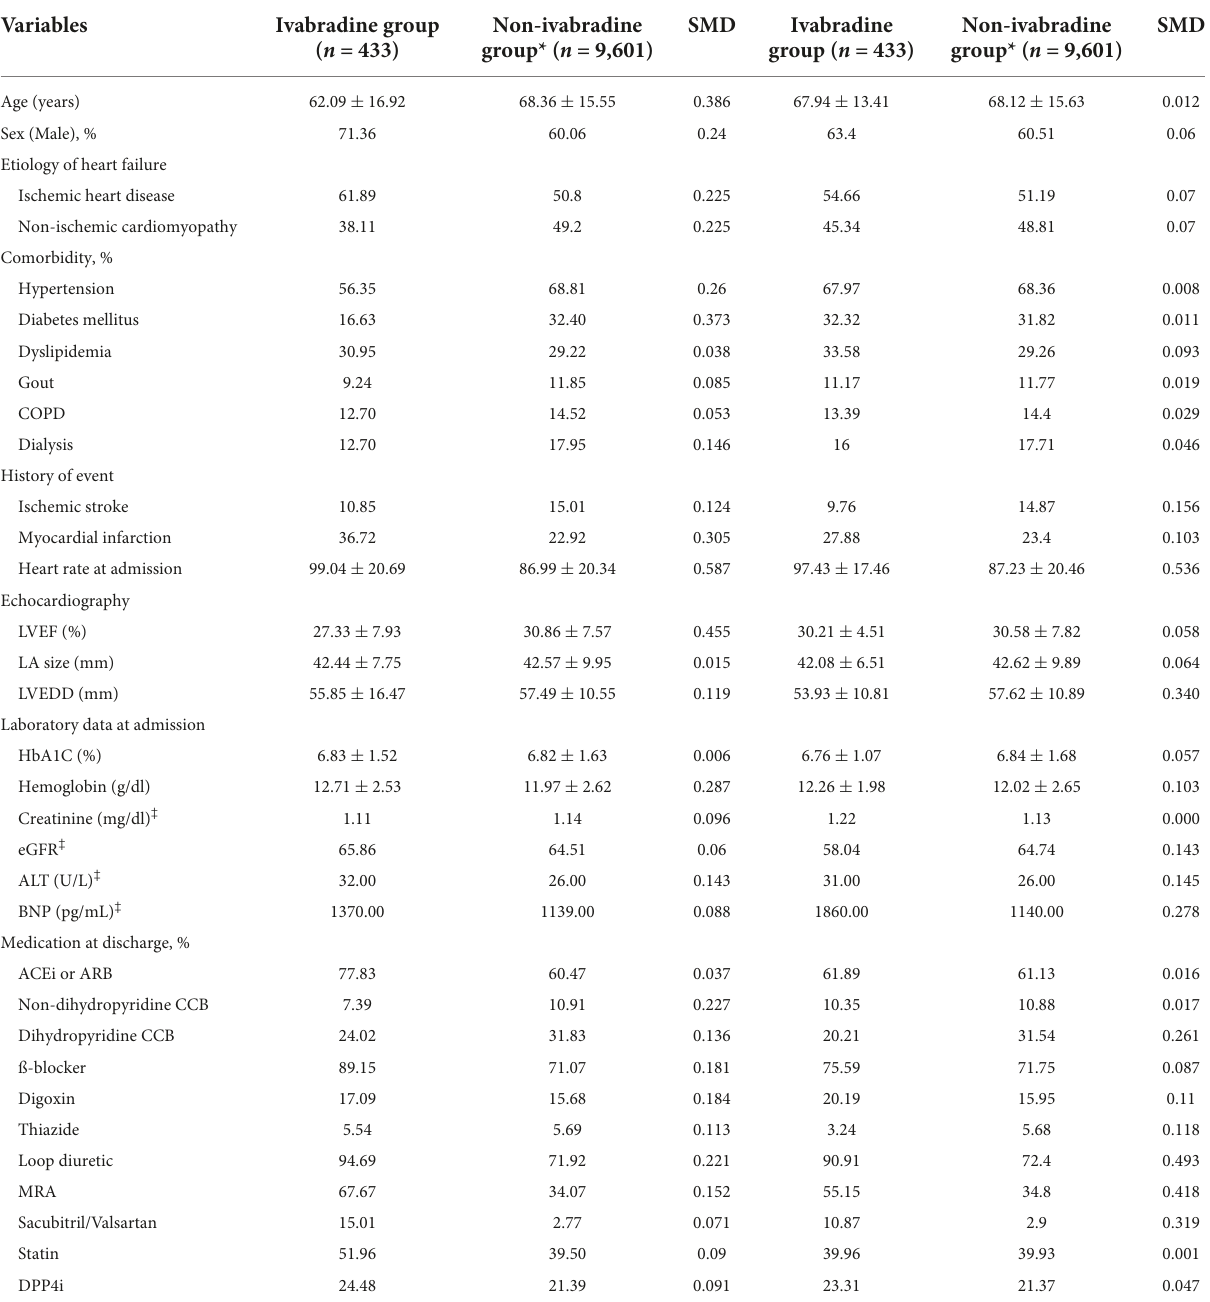
TABLE 1 Baseline characteristics of the patients with heart failure with reduced ejection fraction. Before propensity score